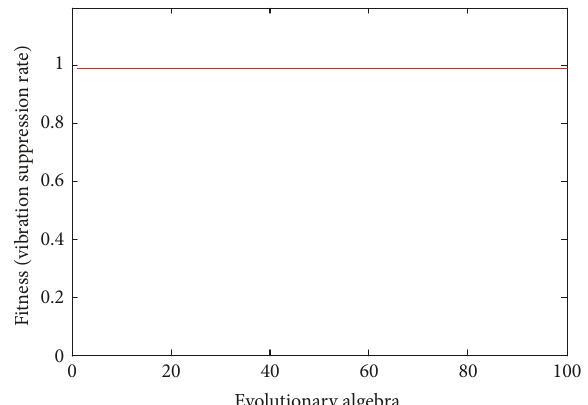
Figure 21: The fitness curve calculated by the genetic algorithm. Table 8: Comparison of data before and after optimization. Parameter Before optimization After optimization 𝐿 /𝐷 1.25 1.0342 𝑝